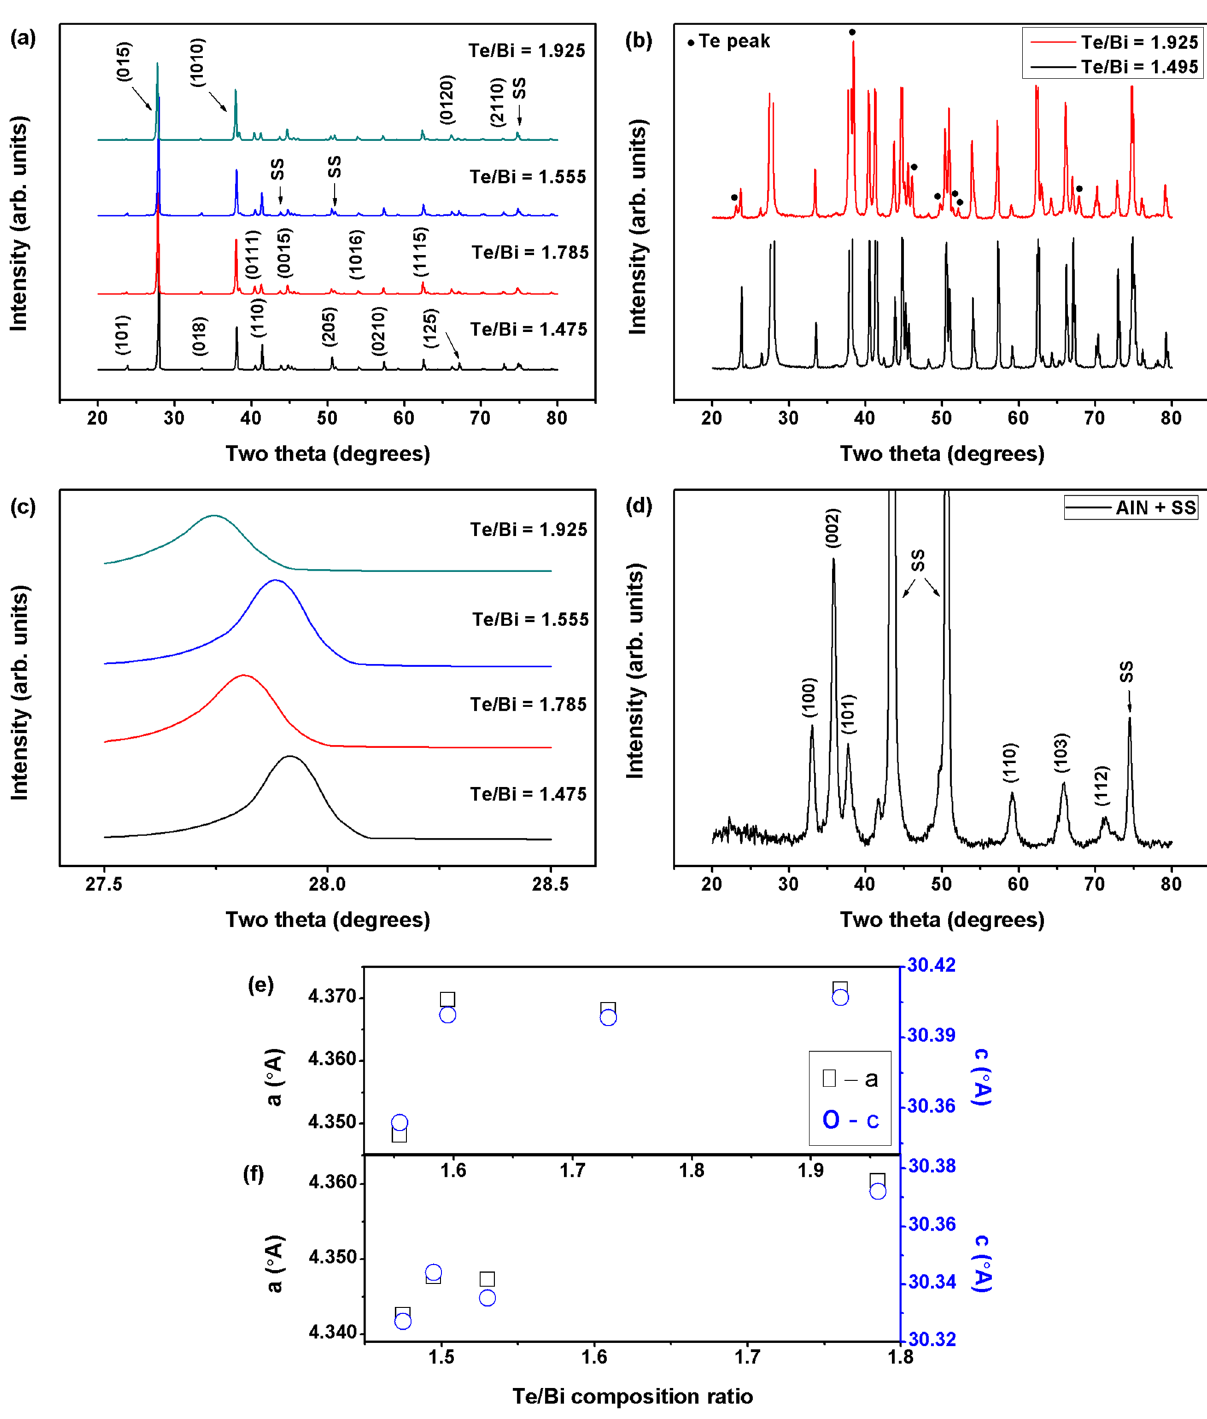
Figure 3. Room temperature (RT) X-ray diffraction (XRD) patterns for the ( a ) selected bismuth telluride (Bi–Te) thin films deposited at high substrate temperatures, ( b ) selected thin films where high intensity Bi–Te peak data was removed for better visualization of the less intense Te peaks, which were observed due to the deviation from stoichiometry, ( c ) selected thin films illustrating the peak shift associated with the Bi–Te main (015) peak, and ( d ) aluminum nitride (AlN) thin film deposited on polished stainless steel foil at high substrate temperatures. The a-axis lattice parameter and c-axis lattice parameter of the Bi–Te thin films as a function of Te/Bi composition ratio, determined from XRD patterns: ( e ) with adhesion layer and ( f ) without adhesion